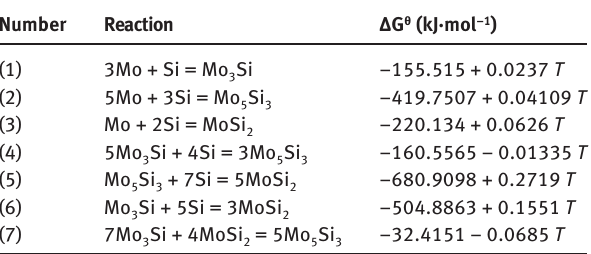
Table 1: Chemical reaction and standard free energy change [9] Number Reaction